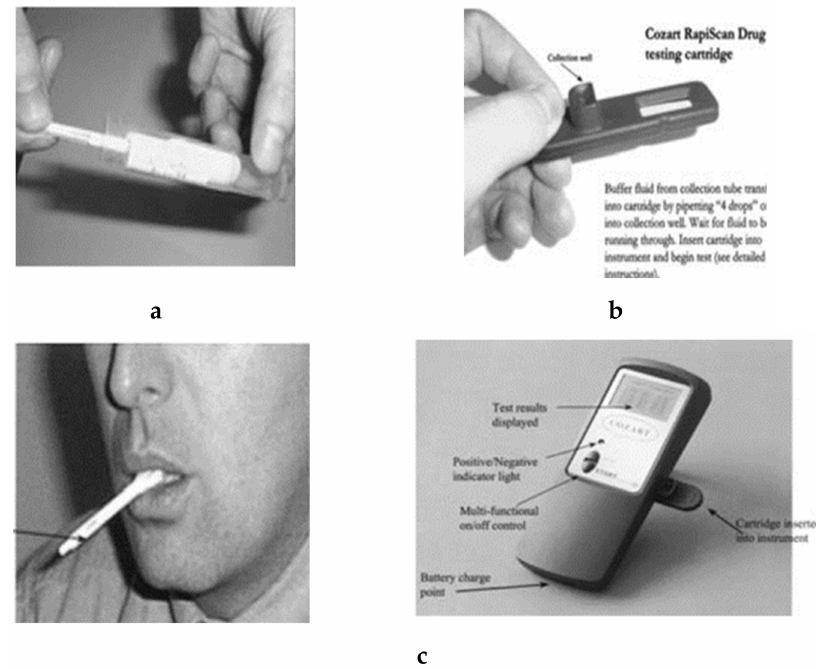
Figure 12. Cozart Rapiscan device. ( a ) The Cozart RapiScan Saliva Collection, ( b ) The Cozart RapiS- can Drug testing cartridge, ( c ) The Cozart RapiScan Instrument with cartridge inserted (reproduced with permission from ASTM International